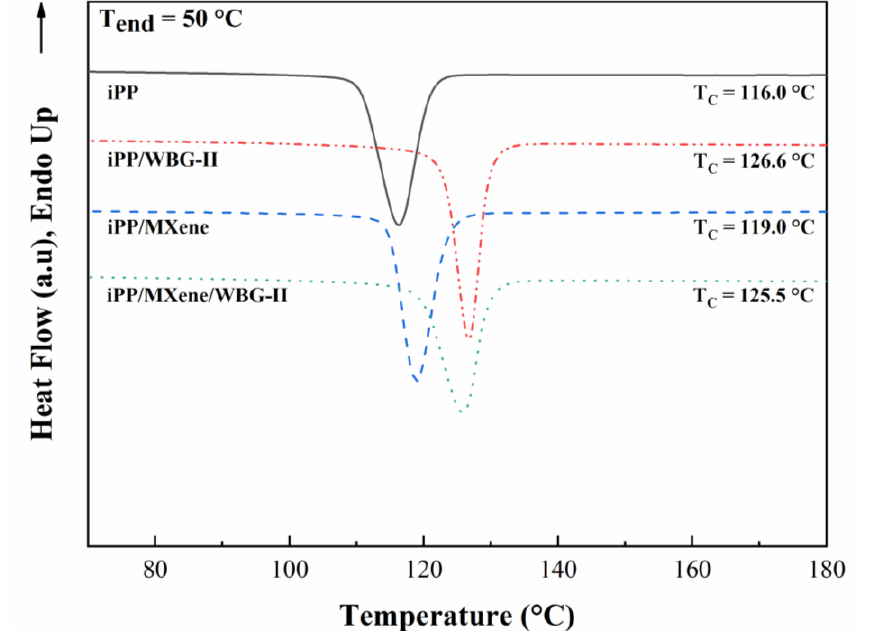
Figure 4. DSC cooling curve at the T end = 50 °C.